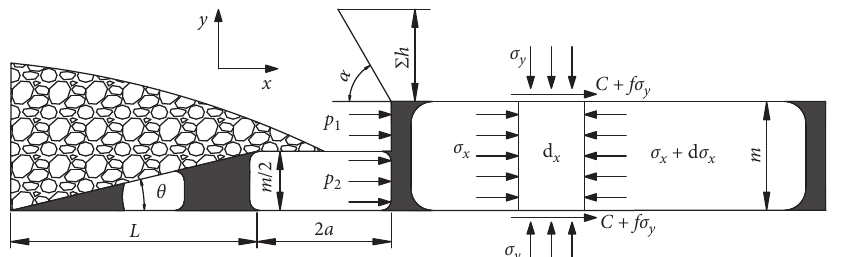
Figure 2: Limit equilibrium mechanical model in the LMSG.